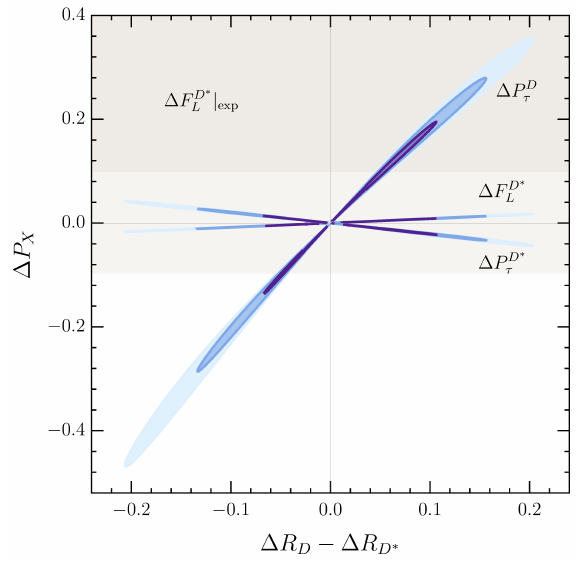
Figure 2. Deviations of the polarization asymmetries compared to the SM as a function of ∆ R D − ∆ R D ∗ , where ∆ X ≡ X / X SM − 1. The predictions are obtained using the fit in Fig. 1 (continuous lines). In gray, the experimental value of ∆ F D ∗